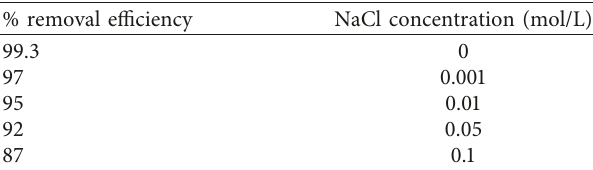
Table 3: Effect of ionic strength on the %RB